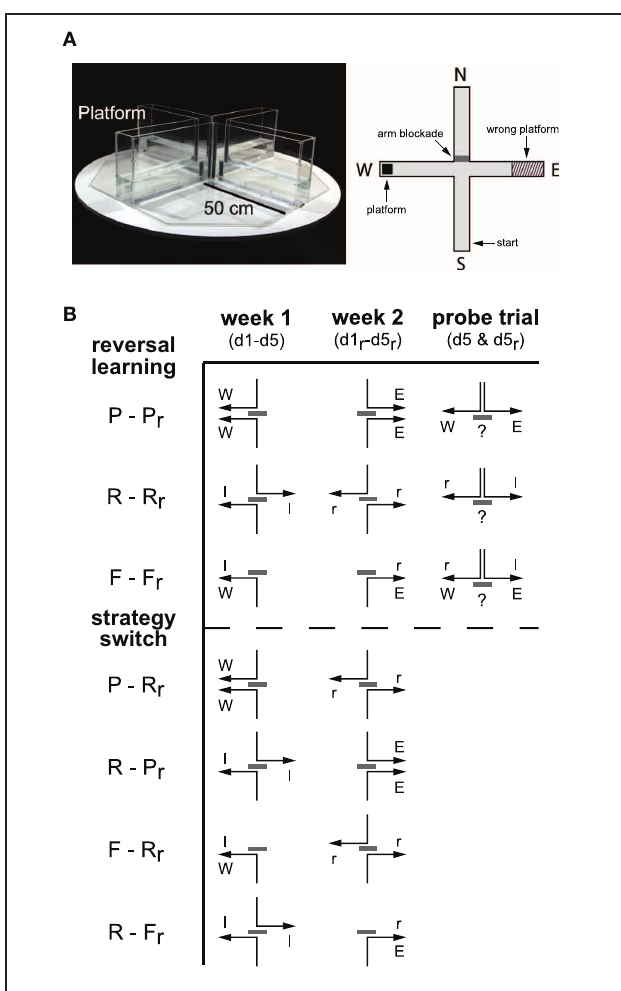
FIGURE 1 | Spatial navigation in the water-cross maze. (A) Photo and schematic drawing of the water-cross maze (WCM) depicting an exemplary constellation of starting point, blocked arm, platform position, and wrong platform area oriented toward the four cardinal points [North (N), East (E), South (S), West (W)]. Note that a flexible wall was used for arm blockade of the arm opposite to the start arm, thus rendering the cross-maze a T-maze during each trial. (B) Scheme of the track to the platform for 5 days learning (d1–d5) in the 1st week, 5 days relearning (d1 r –d5 r ) in the 2nd week and a probe trial on day 5 after the learning trials in both weeks (d5 and d5 r ). Place (P), response (R), and free choice (F) learning protocols were employed during learning and relearning (r) within one modality (reversal learning) or between modalities (strategy switching). Gray bars represent the arm blockade, arrows represent the reinforced track and cardinal points [West (W), East (E), left (l), right (r)] for allocentric and egocentric strategies,